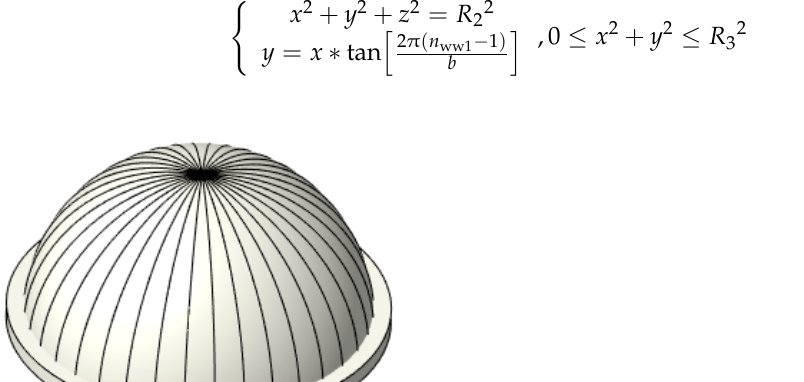
n ‐ th concentric circle measuring track from the h is the distance of the where wt1 wt1 n lower end of the flange, 2 R is the radius of the outer surface of the spherical shell, and Figure 5. The meridian trajectory. Figure 5. The meridian trajectory. R is the radius of the intersection of the outer surface of the spherical shell and the upper 3 end of the flange.